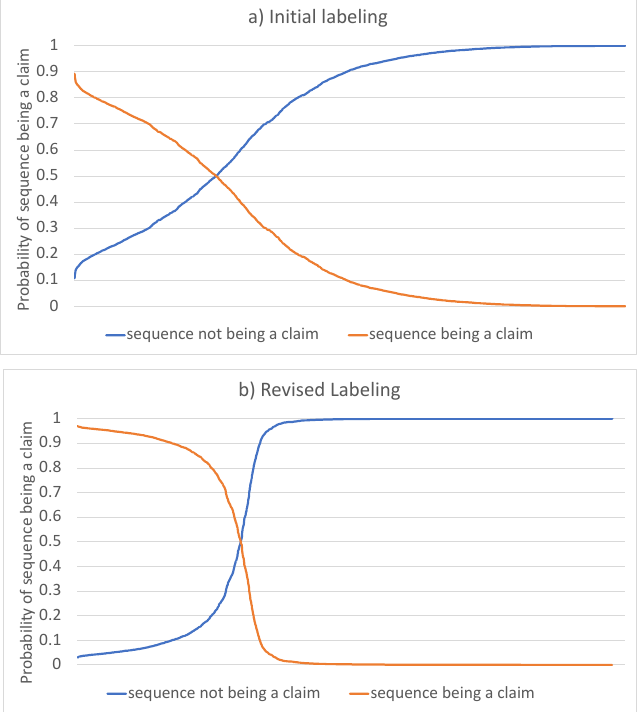
Figure 7. Sorted probabilities with ( a ) initial labeling and ( b ) revised